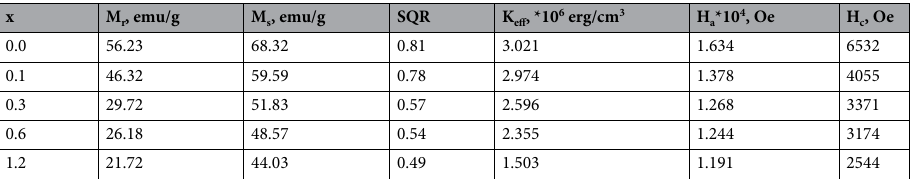
Table 2. The M r residual magnetization, M s saturation magnetization, SQR squareness ratio, k eff effective constant of magnetocrystalline anisotropy, H a anisotropy field and H c coercive field at room temperature.